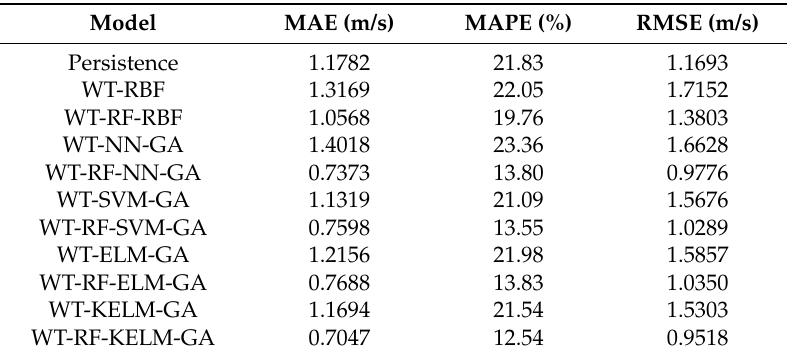
Table 4. Comparison of the evaluation indices of the models. MAE: mean absolute error; RMSE: root mean squared error; WT: wavelet